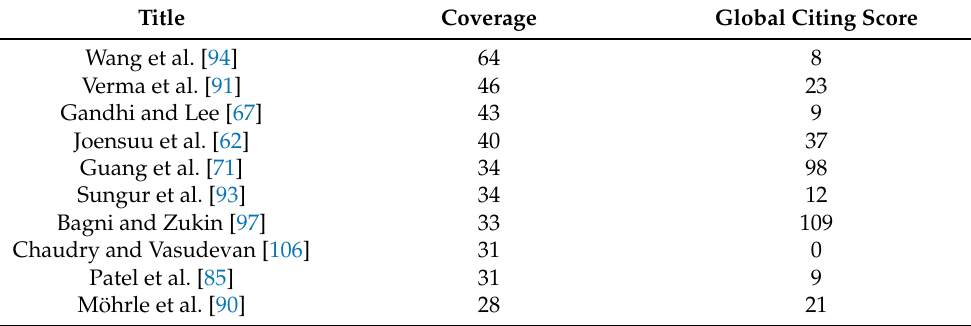
Table 5. Top 10 citing papers in Cluster #2 identified using DCA.